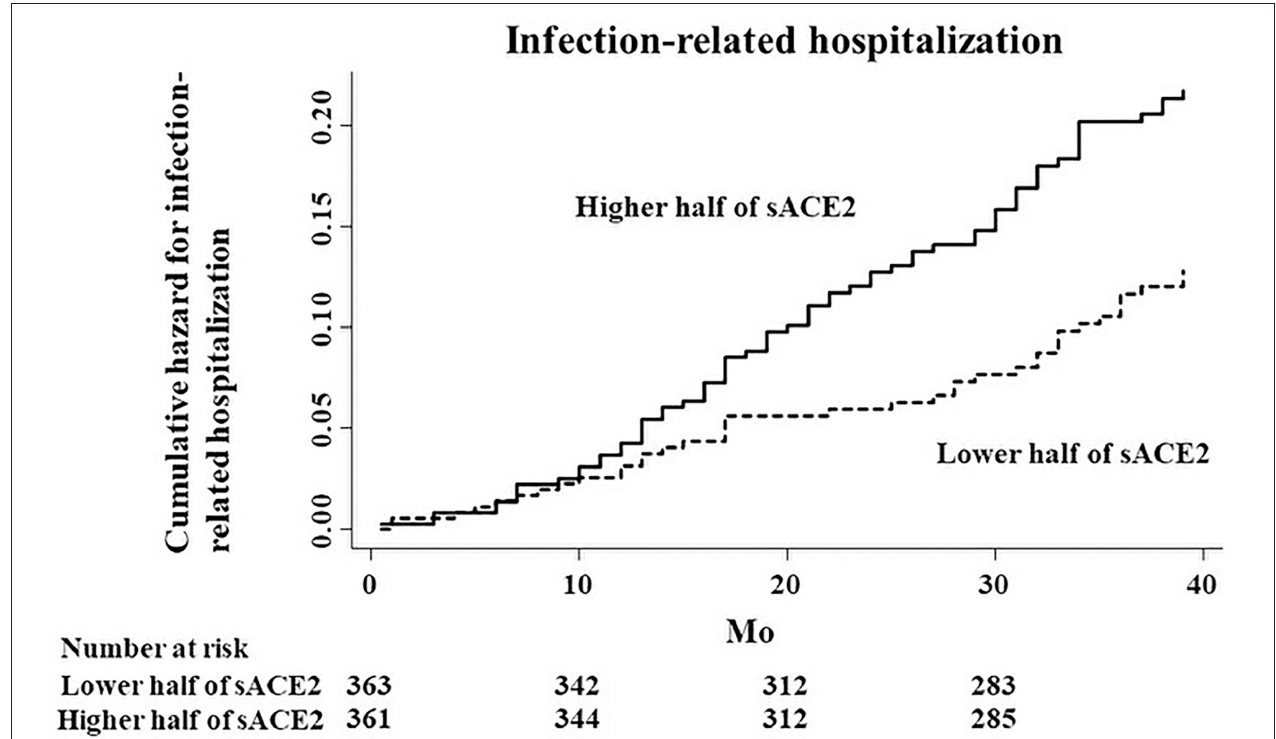
FIGURE 2 | Cumulative hazard curves for infection-related hospitalization by half of the study population according to serum ACE2 (sACE2) levels.